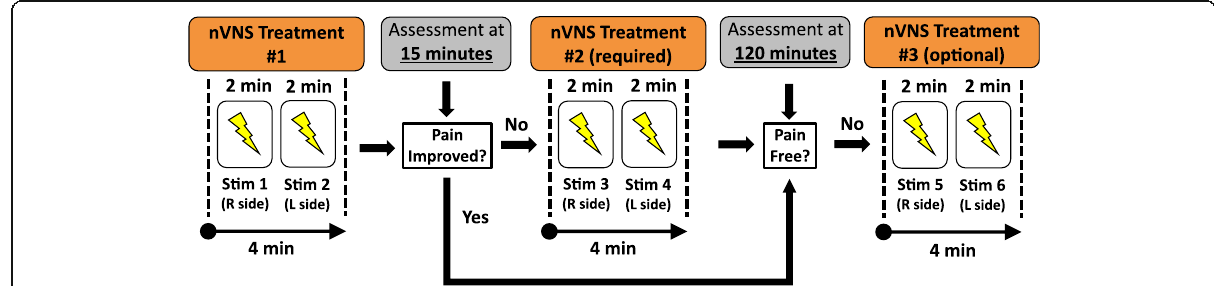
Fig. 2 PRESTO Treatment Paradigm. Abbreviations: L, left; nVNS, non-invasive vagus nerve stimulation; R, right; Stim,